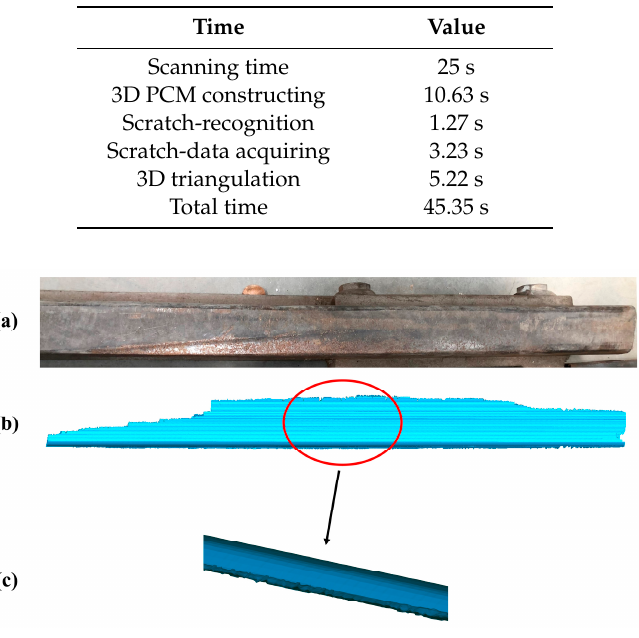
Figure 19. The practical damaged rail and final result in the second experiment. ( a ) The practical damaged-rail; ( b ) The final complete closed mesh model of the practical damaged rail; ( c ) The local magnified model of b.